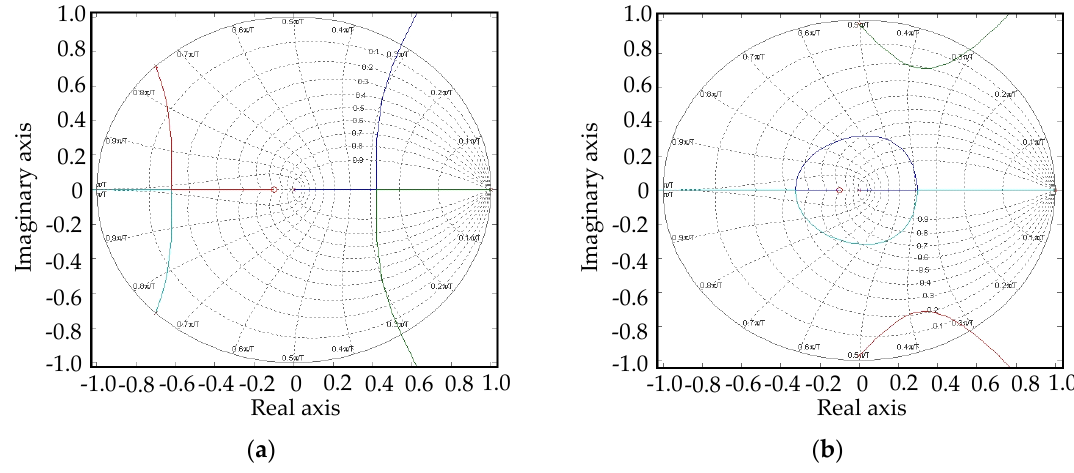
Figure 13. Root locus plot of control system at different sampling frequency. ( a ) Sampling frequency is 2.0 kHz; ( b ) Sampling frequency is 4.0 kHz.